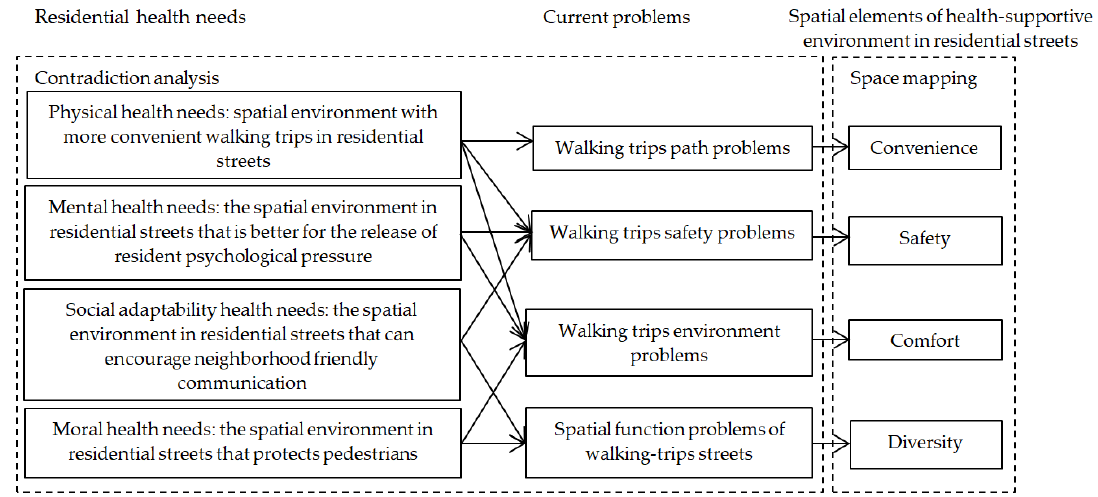
Figure 5. Formative logic of spatial elements of a health-supportive environment in residential streets.